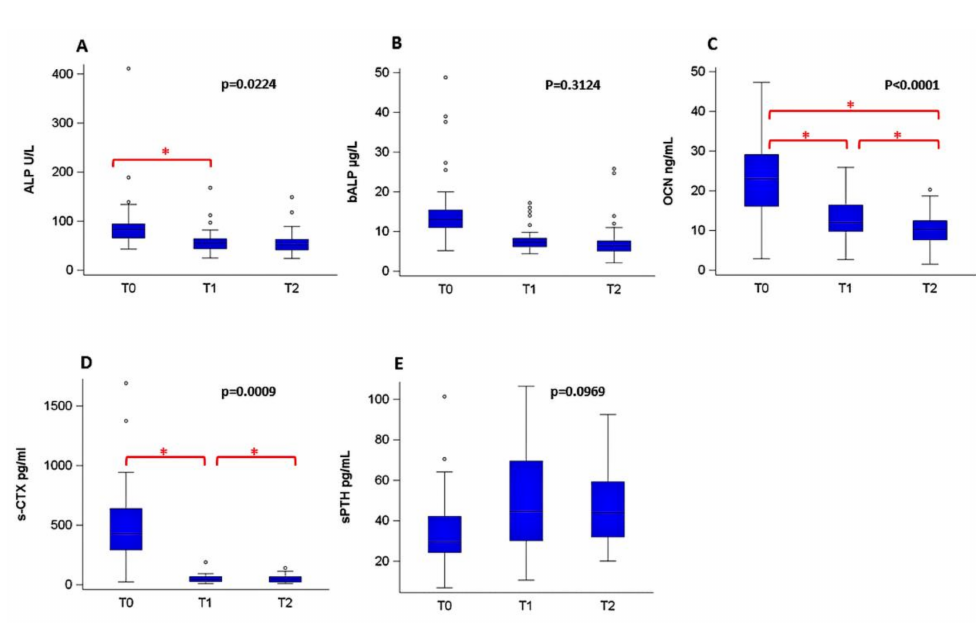
Figure 3. Serum bone turnover marker (sBTM) changes over time. Box-plot shows sBTMs measured at different time-points 0, 1, 2. Panel ( A ) for alkaline phosphatase (ALP), panel ( B ) for bone-alkaline phosphatase (bALP), panel ( C ) for osteocalcin (OCN), panel ( D ) for carboxyterminal-crosslinked- telopeptide of type I collagen (s-CTX) and panel ( E ) for parathyroid hormone (s-PTX). The line inside the box represents the median value, the height of the box is the interquartile range, and the circles represent the outlier values. The p value refers to the main effect of time from nonparametric repeated-measures analysis of variance (ANOVA). * Significant p value ( p < 0.005) from post hoc multiple comparison